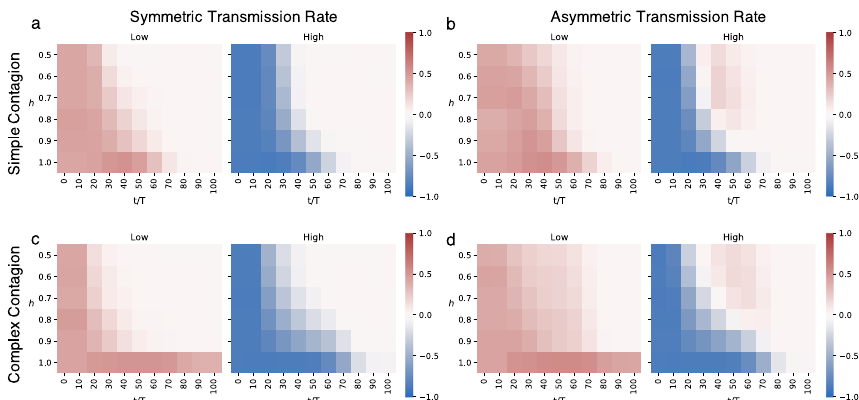
Fig. 3 Information spreading equality for homophily BA with different levels of homophily h . We plot the spreading equality for Homophly BA networks with low and high minority seeding portions. Each plot is a heatmap, where the x‑axis represents the relative time t / T , the y‑axis represents the graph’s homophily h , and the color represents � I ( t / T ) . Recall that � I ( t / T ) = 0 represents equality. At low minority seeding, the lower h values, the more information access equality. This holds across all processes. However at high minority seeding portion, the behavior depends on the symmetry of the transmission. Under symmetric transmission rates (shown in a and c ) with high minority seeding portion, lower h values achieve more information access equality. Under asymmetric transmission rates (shown in b and d ) with high minority seeding portion, lower h values increase to zero, then become positive, before finally decreasing to zero. This makes it hard to judge which h value achieves more equality when one has an asymmetric transmission and high minority seeding